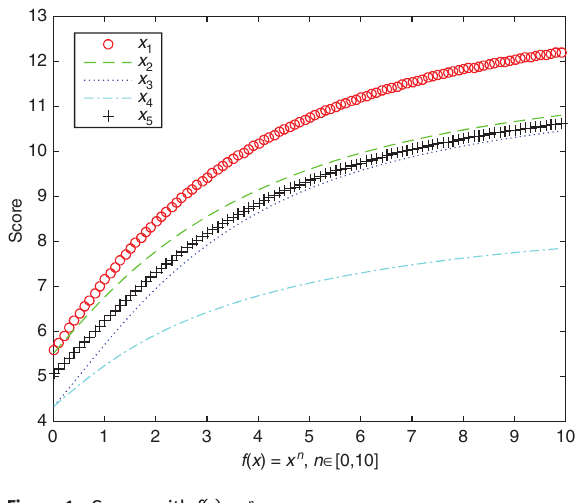
Figure 1: Scores with f ( x ) = x n .